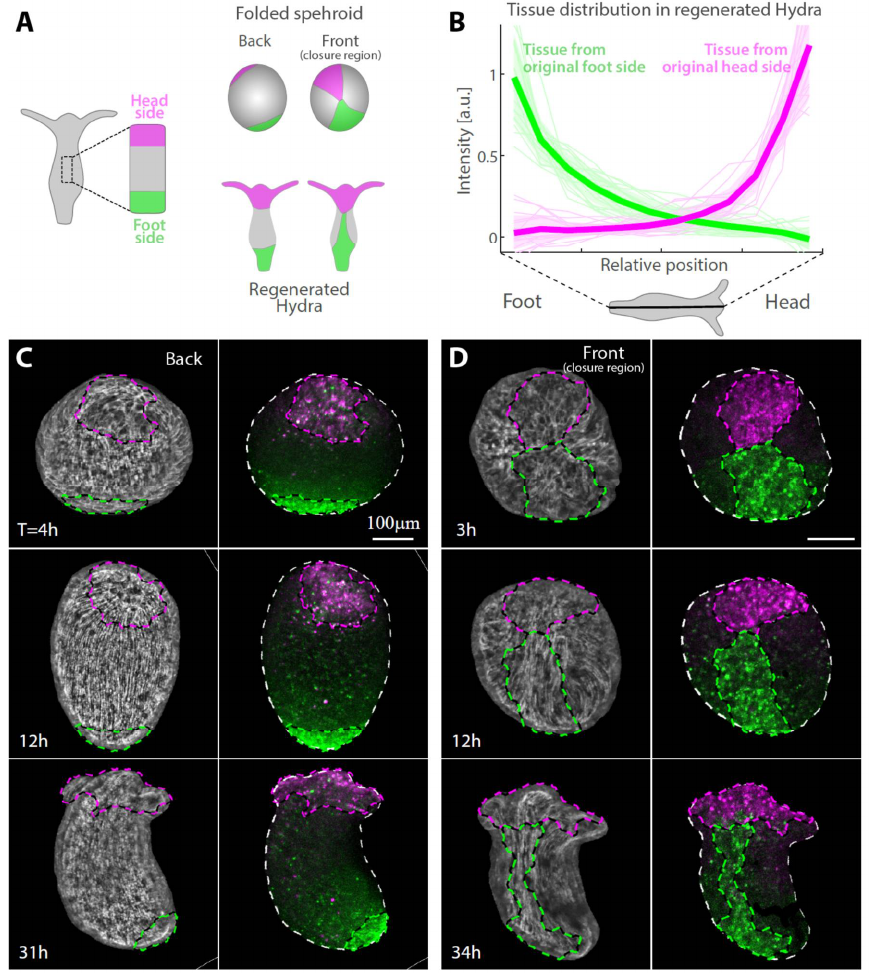
Figure 2. Tissue reorganization during strip regeneration. ( A ) Schematic illustration of the tissue reorganization during regeneration of an excised strip differentially labeled at its head-facing side and its foot-facing side (as in Figure 1F). The regenerating tissue is depicted from opposite viewpoints at an early (top) and late (bottom) stage of the regeneration process. ( B ) The redistribution of tissue originating from tissue strips labeled either at their head-facing side (magenta) or foot-facing side (green) was determined from the relative labeling intensity in the regenerated animals. Graphs showing the relative label intensity along the body axis of animals regenerating from tissue strips labeled at either their head-facing side (thin lines, magenta; N = 19) or their foot-facing side (green; N = 19) by uncaging Abberior CAGE 552 (Methods). The position-dependent label intensity is determined from the normalized fluorescence signal intensity within segments along the regenerated animal’s body axis averaged over pairs of projected images of each animal taken from either side (Figure S1). The population mean of the relative label intensity averaged over all regenerated animals examined (thick lines) and the standard deviation within each population (shaded regions) are also shown. ( C , D ) Tissue dynamics in regenerating tissue strips differentially labeled at their head-facing side with uncaged Abberior CAGE 552 (magenta) and their foot-facing side with uncaged Abberior CAGE 635 (green) in ( C ) or vice versa in ( D ) (see Methods). Projected spinning disk confocal images from time-lapse movies are shown for a sample imaged from the side opposite the closure region (back; C , Movie S2) or the side containing the closure region (front; D , Movie S3). For each time point, an overlay of the fluorescent markers labeling the head-facing side of the strip (magenta) and the foot-facing side of the strip (green) are shown (right), together with an image of the supracellular ectodermal actin fibers labeled with lifeact-GFP on the basal surface (gray) overlaid with contours depicting the labeled regions